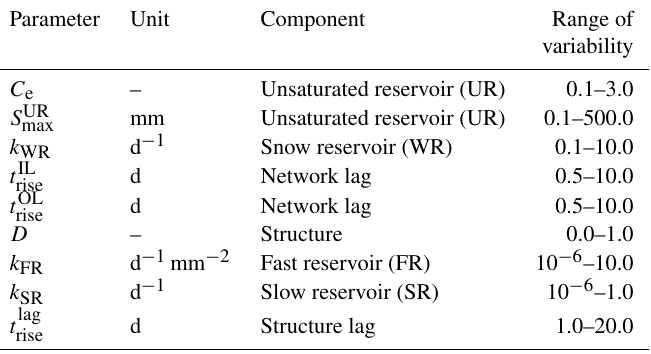
Table A1. Hydrological model parameters with the range of variation used for the definition of the uniform prior distribution. The “compo- nent” column indicates the element (reservoir, lag, or network) where the parameter belongs.